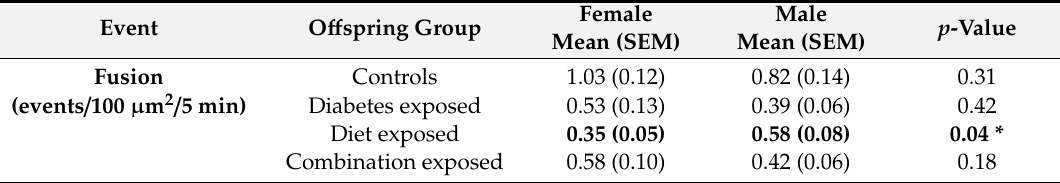
Table 1. An offspring’s sex influences mitochondrial dynamism and morphology in neonatal rat cardiomyocytes.